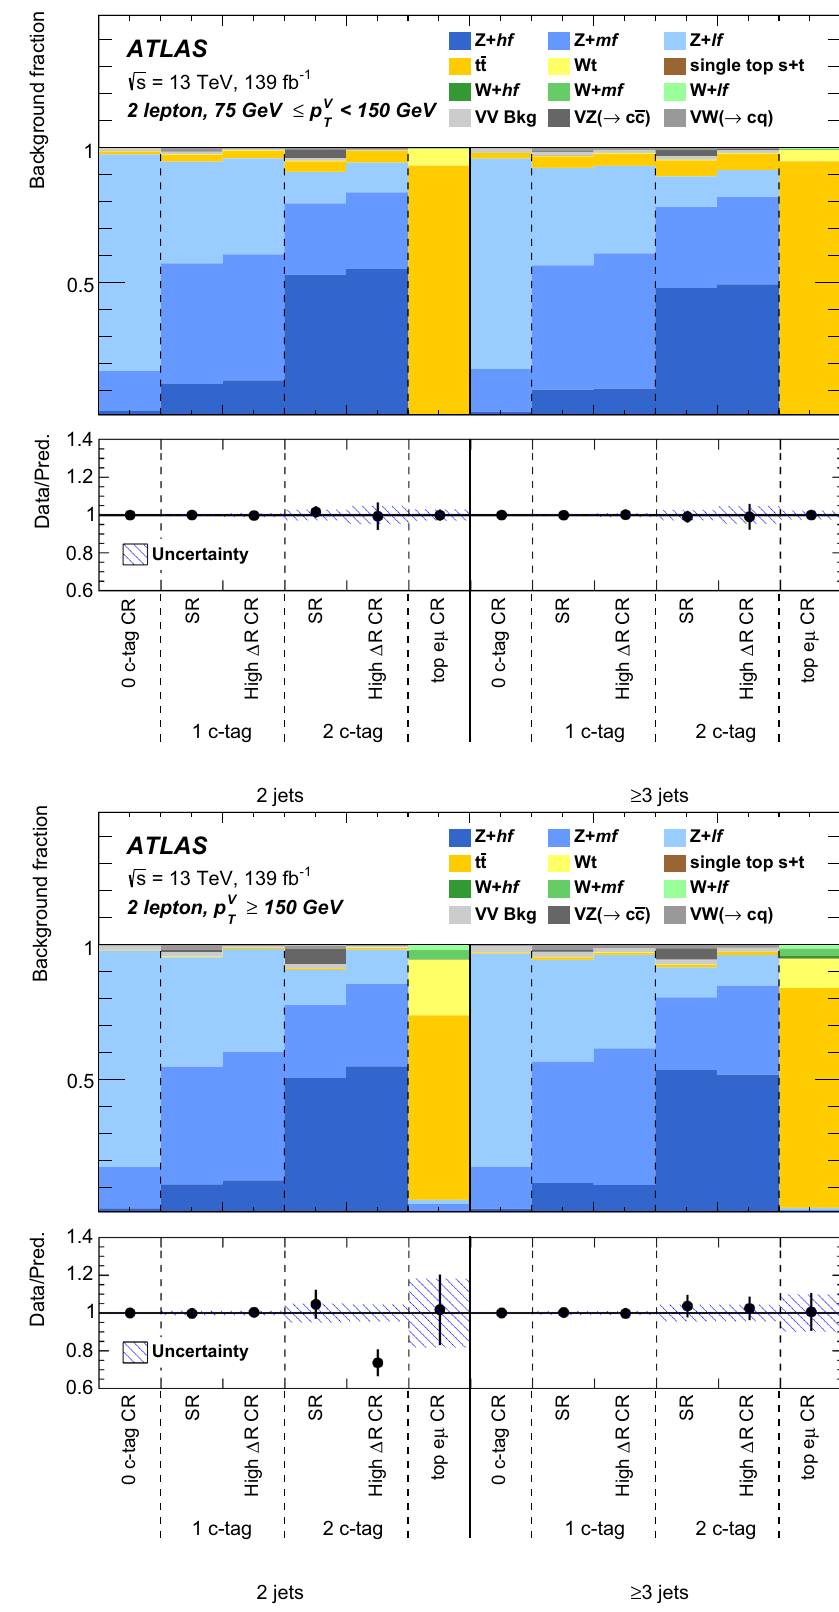
Fig. 17 The background composition in all 2-lepton signal and control regions, for events with < 150 GeV (top) and 75 < p V T > 150 GeV (bottom)